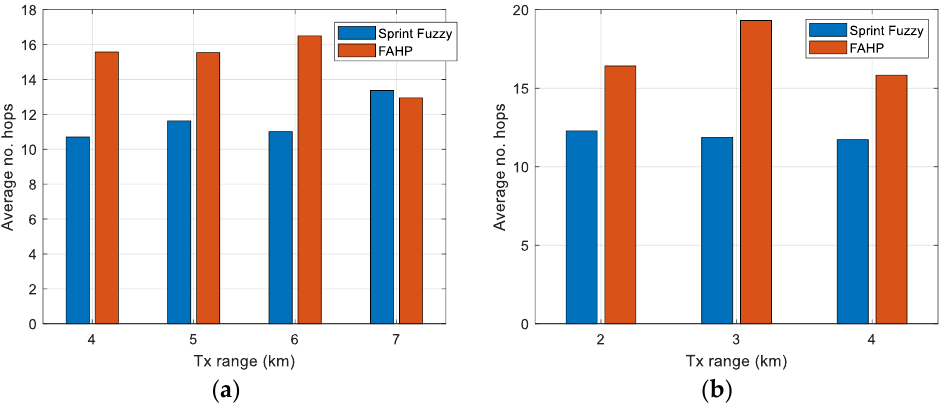
Figure 9. Average number of hops (left bar: SPRINT with fuzzy logic, right bar: FAHP method). Number of nodes: ( a ) 100, ( b ) 400.